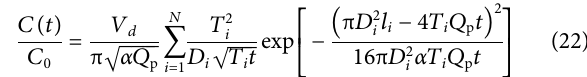
FIGURE 13 | Physical model of multipipe in parallel in one injection- production well.